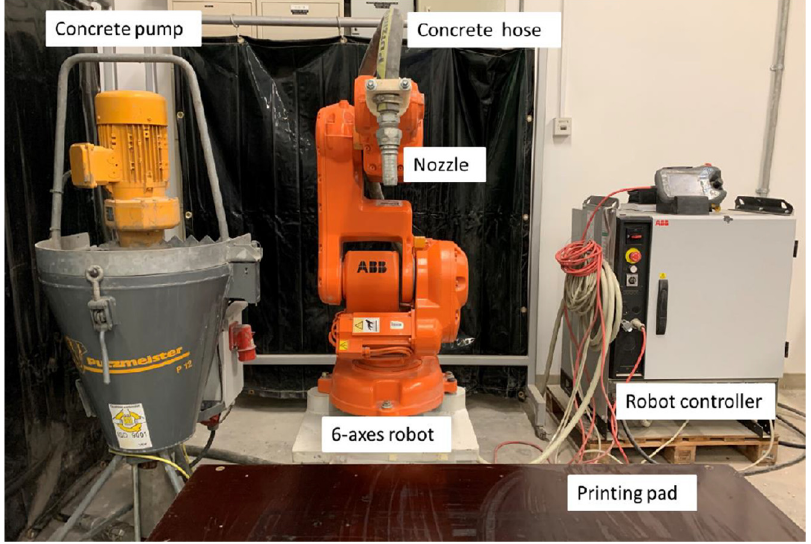
Figure 3. Lab-scale concrete 3D printing setup.